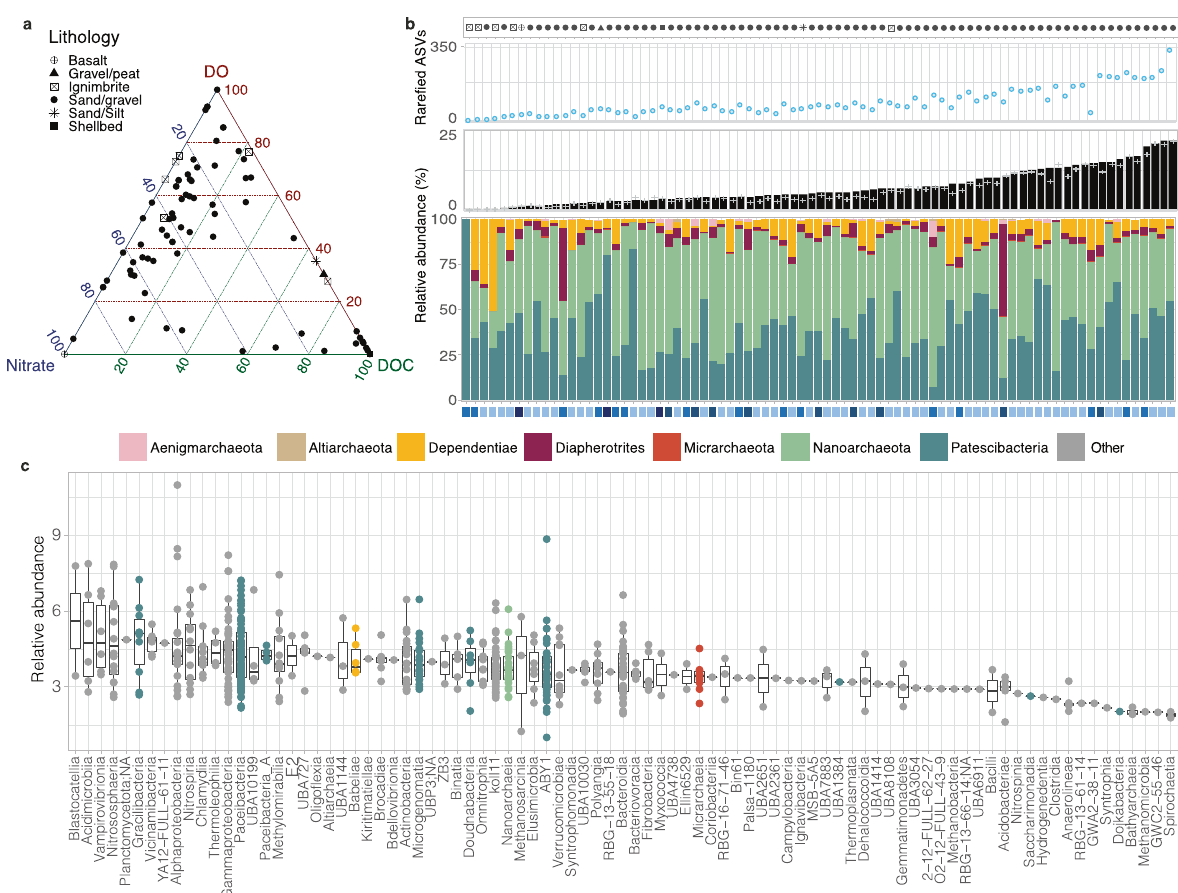
Fig. 1 Distribution and abundance of ultra-small prokaryotes across groundwater sites. a Distribution of groundwater samples along DOC (0 – 26 g/m 3 ), DO (0.37 – 7.5 g/m 3 ) and nitrate-N (0.45 – 12.6 g/m 3 ) concentrations scaled between 0 and 100. b Top plot: Richness of ultra-small prokaryote variants (rare fi ed ASVs) at each site. Middle plot: Proportion of ultra-small prokaryotes compared with the total microbial communities (black bars = OTUs, grey crosses = ASVs). Samples are ordered from least to most abundant. Lower plot: Phylum-level breakdown of amplicon based-relative abundance of Patescibacteria, Dependentiae and DPANN archaea (bottom). Symbol bars indicate aquifer lithology (top symbol bar), and oxygen content (lower symbol bar) with dark to light blue shading representing anoxic, suboxic, dysoxic to oxic groundwater. c Class-level rank abundance curve showing the average relative abundance of each genome across sites. The center line of each boxplot represents the median; the top and bottom lines are the fi rst and third quartiles, respectively; and the whiskers show 1.5 times the interquartile